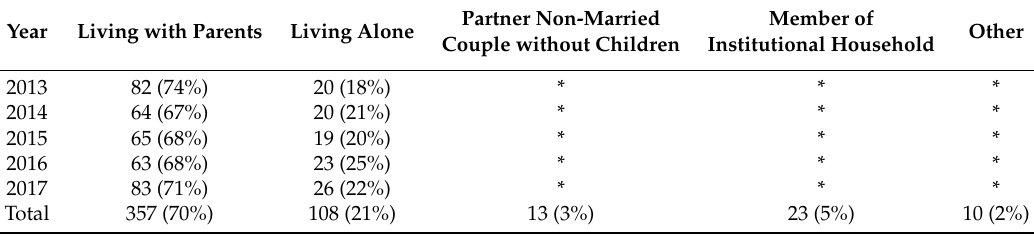
Table 8. Number of suicides among youths under 23 separated out by place in household (percentage of total in year in